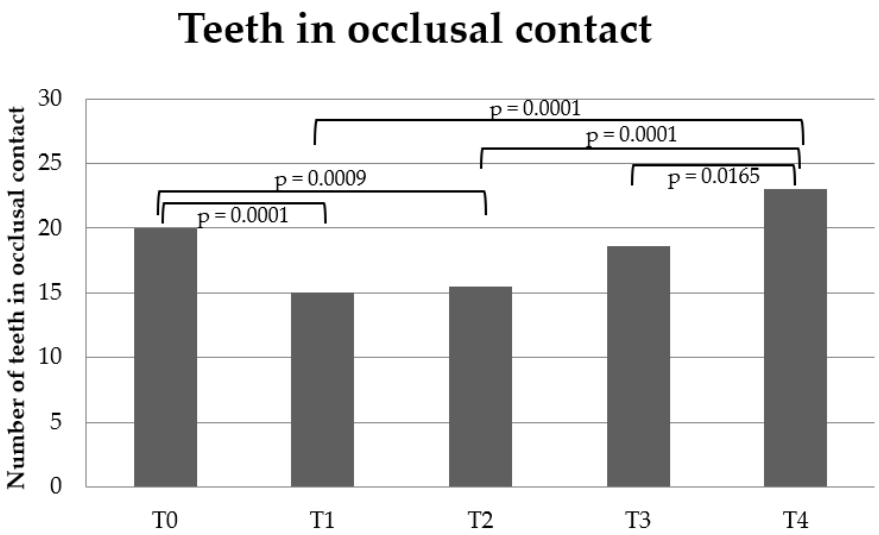
Figure 4. Changes in number of teeth in occlusal contact. The chart shows the number of teeth in occlusal contact at the different treatment phases: Pre-treatment (T0), 1st follow-up after bonding of fixed appliance (T1), during treatment (T2), post-treatment (T3) and at 1st retention follow-up (T4). The significant p -values are shown tested by a mixed-model post hoc test (Bonferroni).